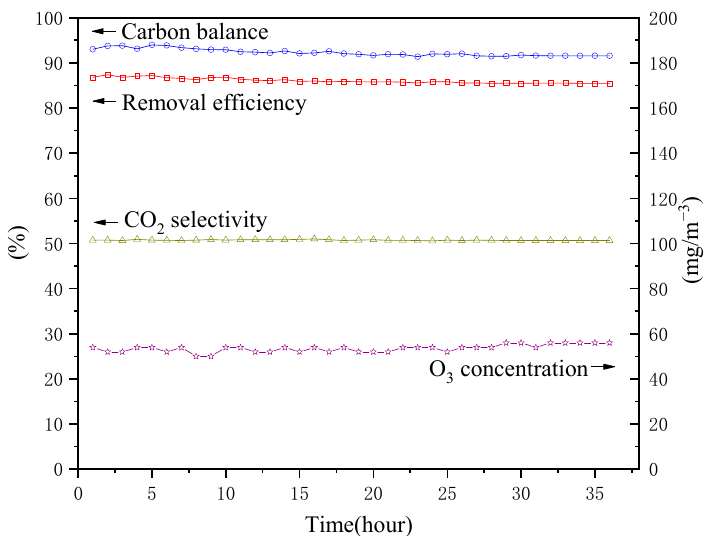
Figure 2. The catalytic stability of ZrMnFe/SEP on the toluene removal over 36 h (RH = 6% and SIE = 750 J/L ).